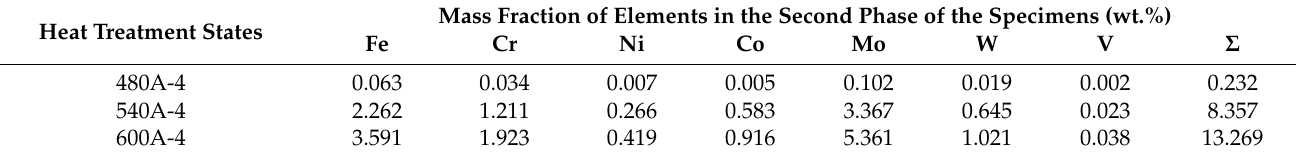
Table 5. Quantitative analysis results of the second phase in the sample. Mass Fraction of Elements in the Second Phase of the Specimens (wt.%) Heat Treatment States Fe Cr Ni Co